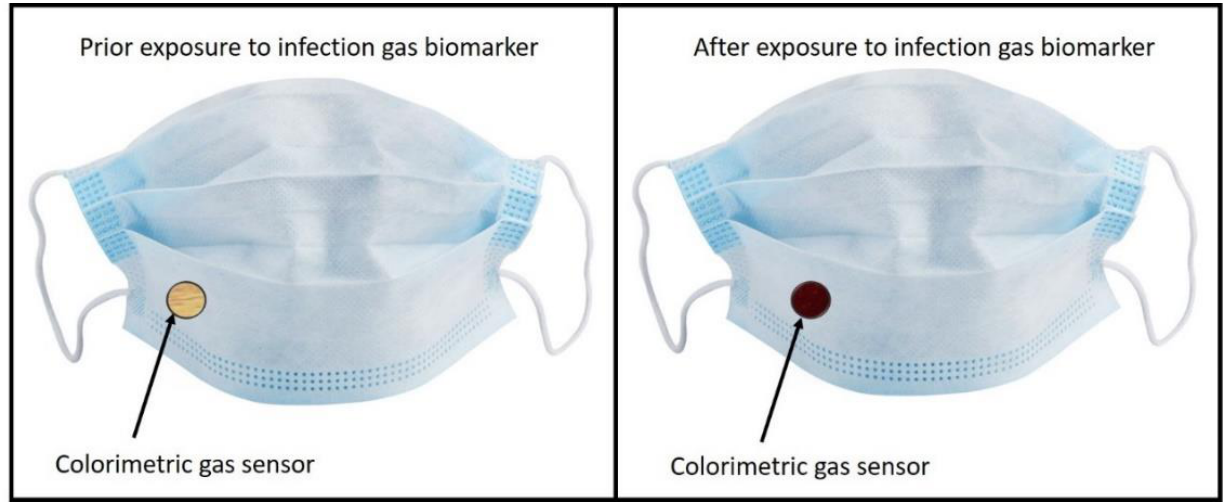
Figure 6. Example of potential technological outlook for the explored sensing method.